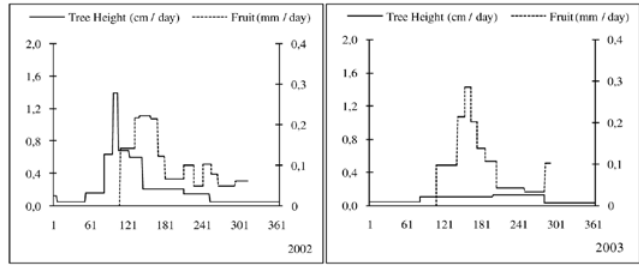
Fig. 8 - Growth patterns of olive tree height (cm/day) and fruit diameter (mm/day) recorded in 2003 compared to tree height and fruit development curves recorded in 2002. Values are averages of 96 tree height and 480 fruit diameter measurements made on Chétoui olive trees.